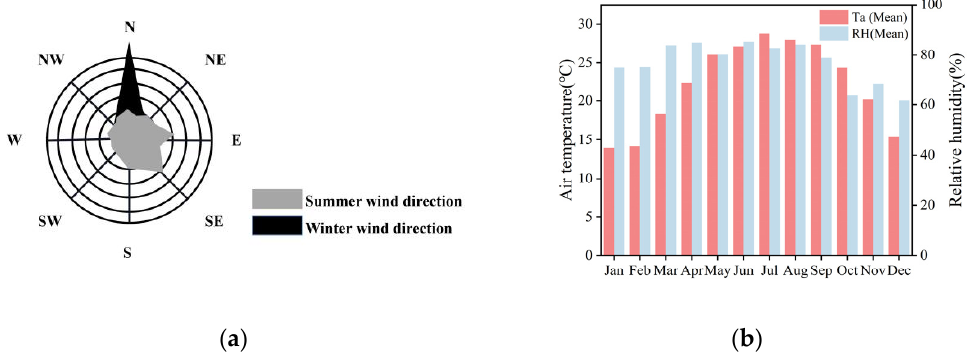
Figure 2. Climate characteristics of Guangzhou. ( a ) Wind direction in summer and winter. ( b ) The annual average air temperature and relative humidity (https://energyplus.net/weather-search/Guangzhou, accessed on 25 October 2022).